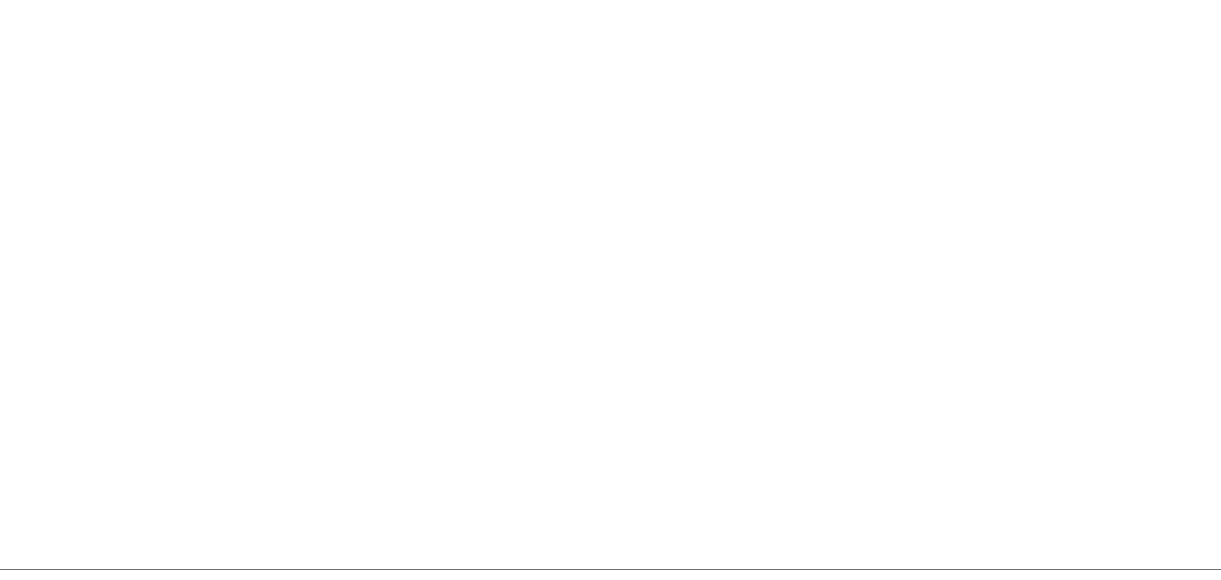
Frontiers in Communication |